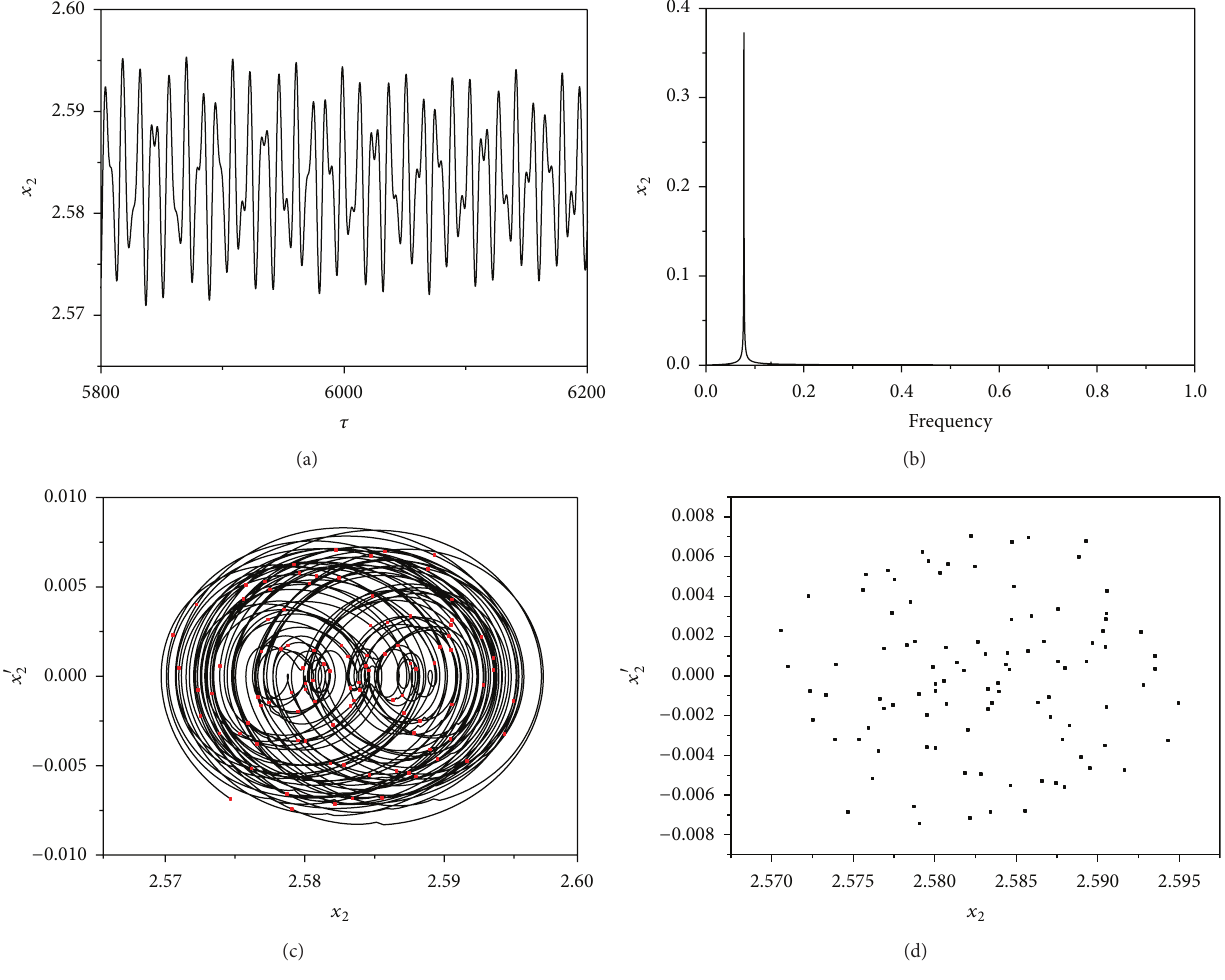
Figure 14: See 𝜔 = 1.30 . (a) Displacement response. (b) Frequency spectrum. (c) Phase-portrait plots. (d) Poincar´e maps.